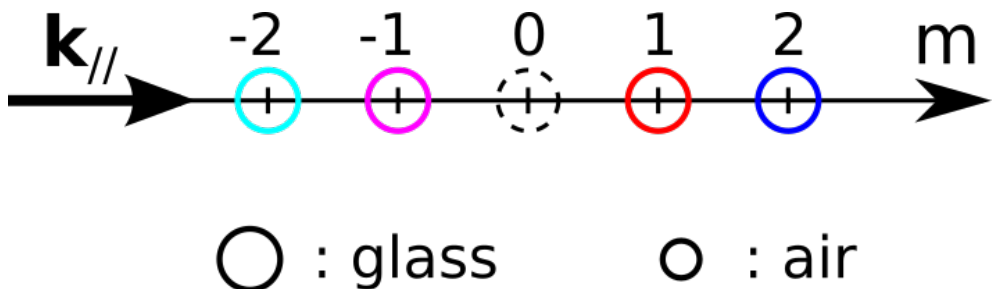
Figure 1. Rayleigh anomalies color code; m is the diffraction order along the direction of propagation.